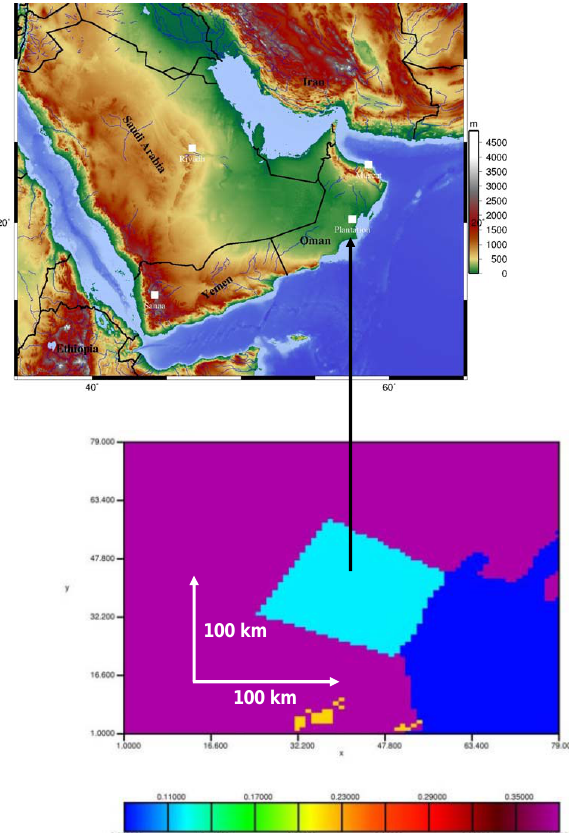
Fig. 4a. Upper panel: location of the plantation in Oman. Bottom Fig.4a Upper panel: Location of the plantation in Oman. Bottom panel: 2D plots of the 14 panel: 2-D plots of the reduction in albedo caused by Jatropha cur- reduction in albedo caused by Jatropha curcas plantations in Oman. 15 cas plantations in